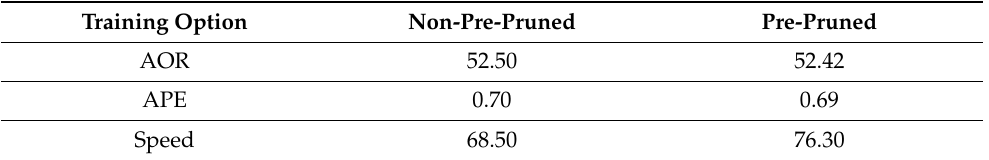
Figure 8. Success and precision plots on OTB2013 dataset with pre-pruned feature network or non-pre-pruned feature network. Table 1. AOR and APE, as well as speed of pre-pruned feature network or non-pre-pruned feature network, on the OTB2013 dataset.